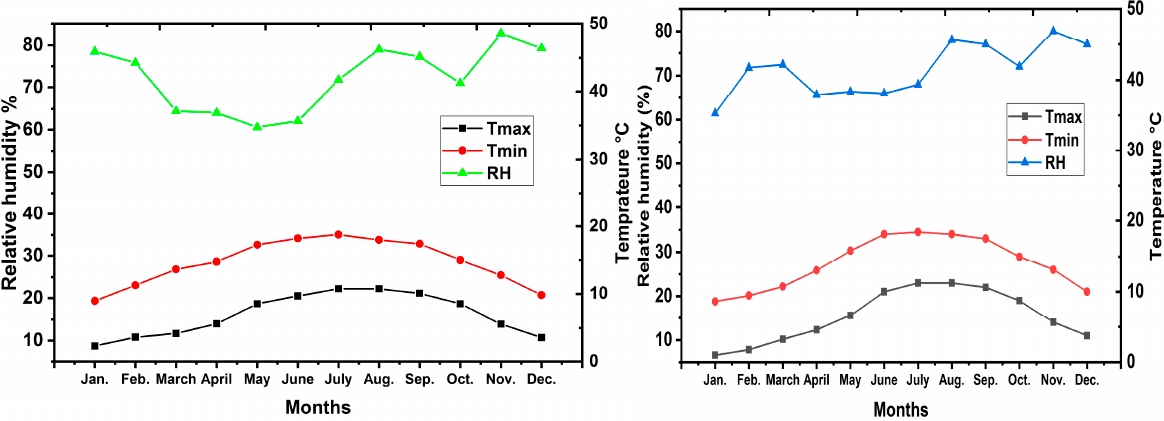
Figure 1. Climatic data of El-Khatatba region-Monthly means of 2018 and 2019.